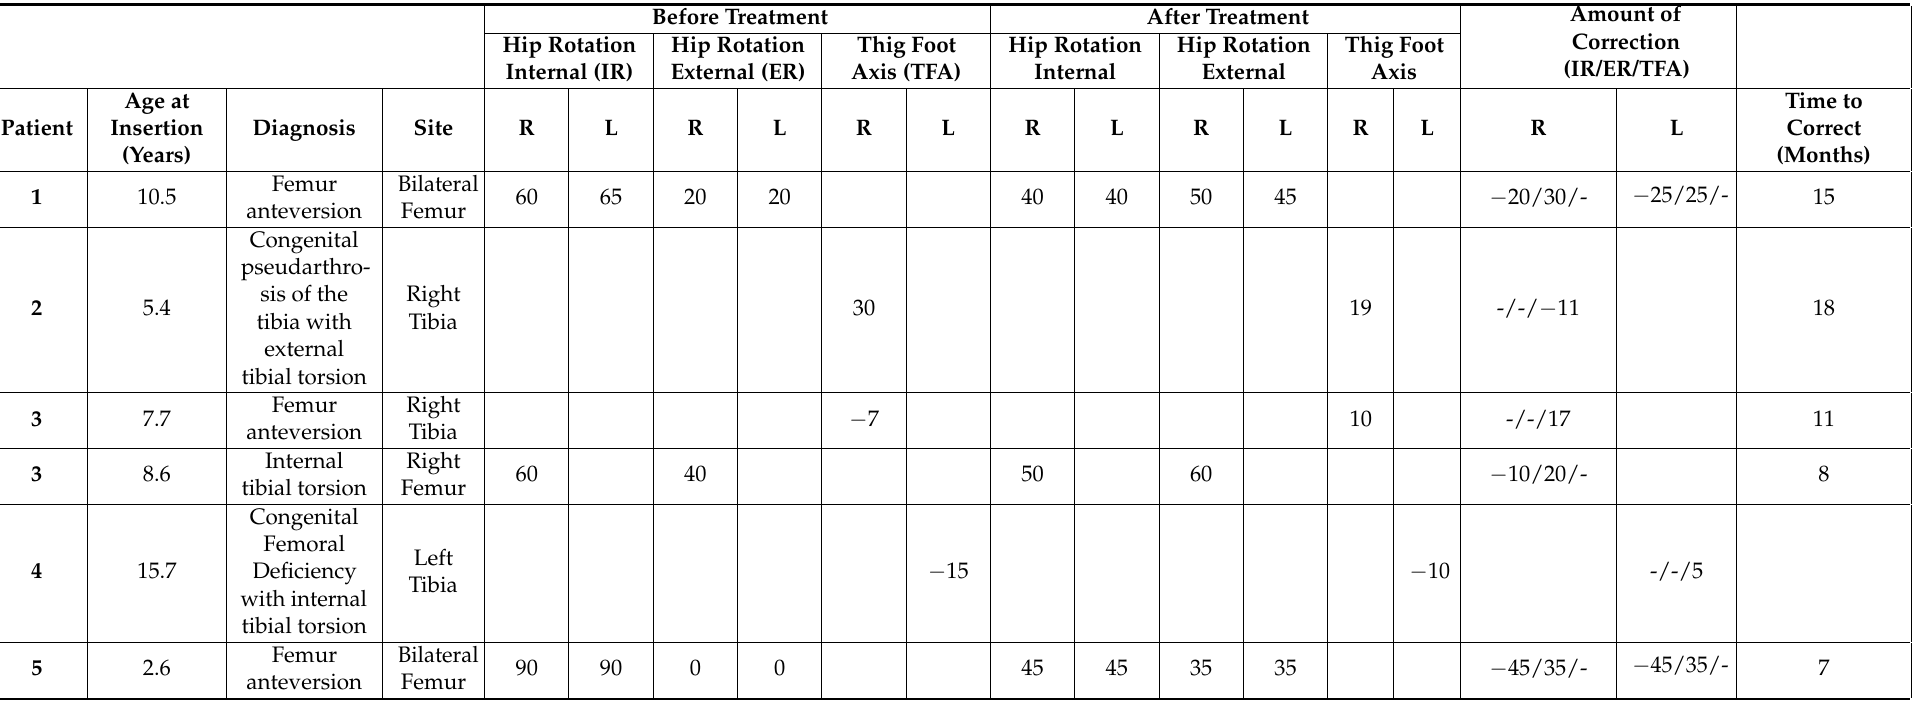
Table 1. Demographics and rotation profiles before and after rotationally guided